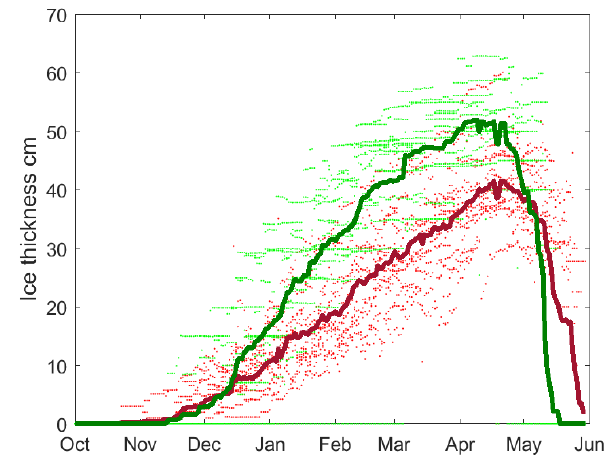
Figure 5. Seasonal development of level ice thickness. Data are based on ice chart information thickness for 14 seasons 2003–2016. The green and red dots are daily level ice thicknesses in the fast ice and pack ice zones for different seasons, the green line is fast ice thickness average over seasons, and the red line is pack ice thick- ness.